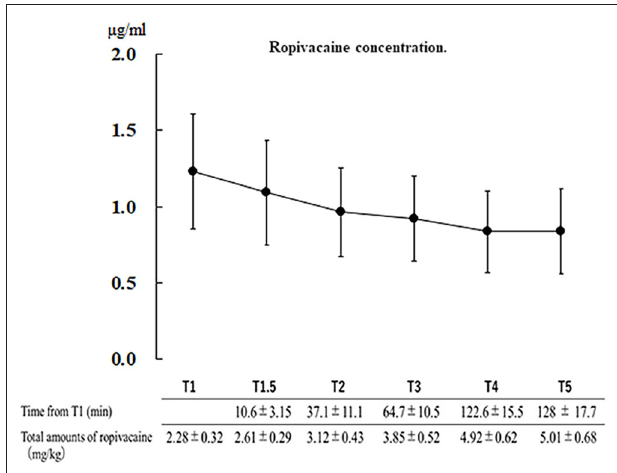
FIGURE 1 | Serum concentration of ropivacaine at each point and injection time relative to the scalp block (T1). Data: mean ± standard deviation. T1.5, additional scalp block; T2, headpin site; T3, surgical site; T4, temporal muscle; and T5, dura mater.